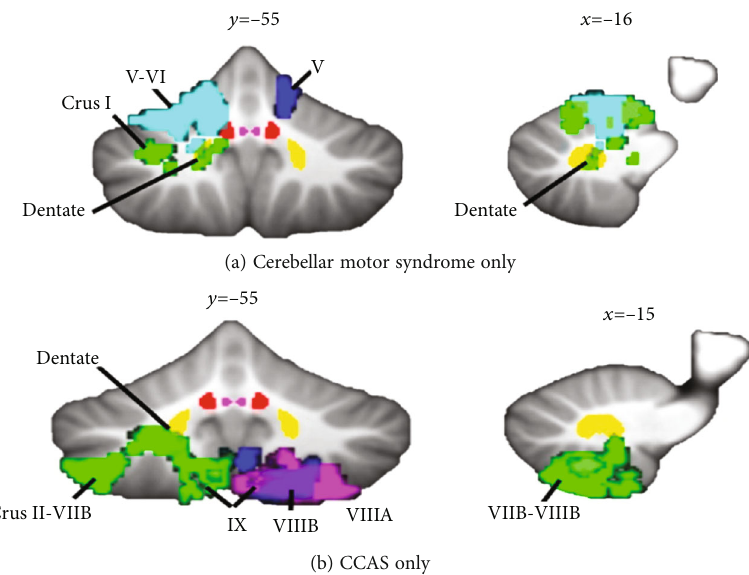
Figure 3: Lesion symptom mapping in patients with cerebellar infarction. Description: (a) Lesions of lobules IV – V of the anterior lobe extending into adjacent lobule VI produce the cerebellar motor syndrome of ataxia but not cerebellar cognitive a ff ective syndrome (CCAS). (b) Lesions con fi ned to posterior lobe lobules Crus II through lobule IX produce the cerebellar cognitive a ff ective syndrome but no motor ataxia. Di ff erent colors represent the lesions of individual patients. Author ’ s diagram developed by Stoodley et al.